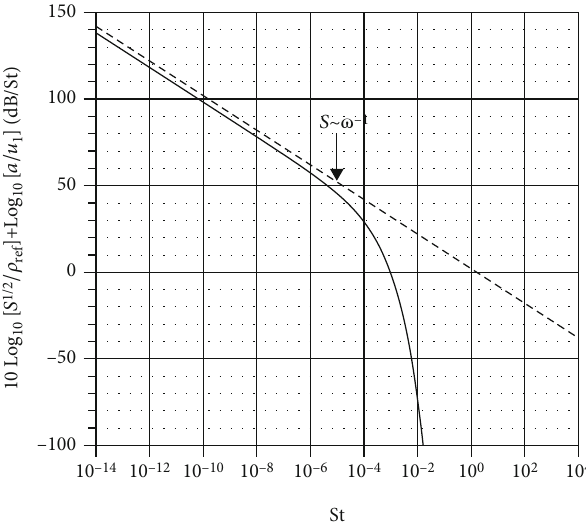
Figure 3: The power spectrum of density outside the region of isotropic turbulence at x = 1/ a .